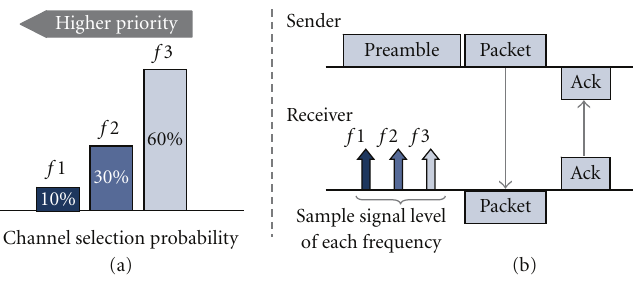
Figure 1: (a) Channel selection probability. (b) One Alert time slot.